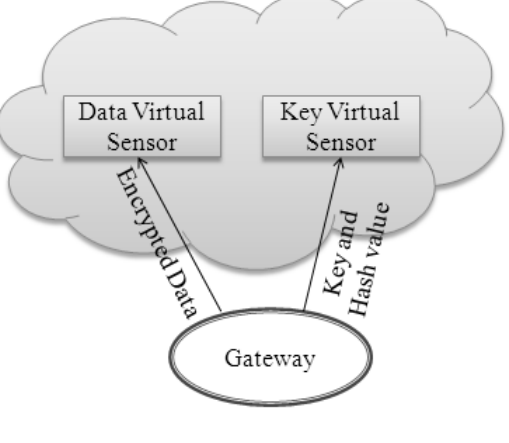
Figure 3. Interface between the gateway and the Virtual sensors (database).